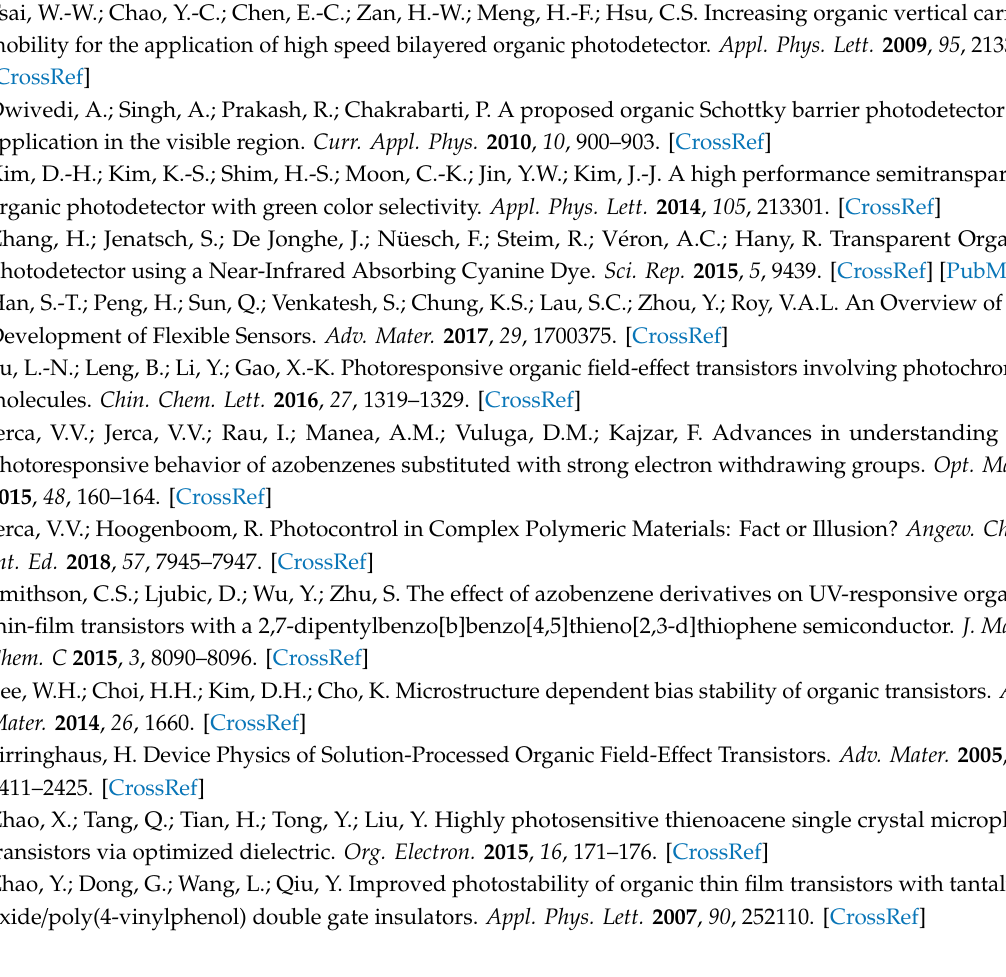
Figure S1. Real thickness data of the produced PVP layers ( d = 60 and 260 nm). Actual thickness values indicated as d = 60 nm and 260 nm were about 55 nm and 255 nm, respectively. Figure S2. Comparison of gate leakage current of the OPTs with two di ff erent thicknesses of PVP ( d = 60 and 260 nm) in the dark. Figure S3. Transfer curves of the OPTs with two di ff erent thicknesses, d , of PVP, in the dark and under di ff erent intensity light exposure (3 and 12 mW / cm 2 ); (a) d = 60 nm and (b) d = 260